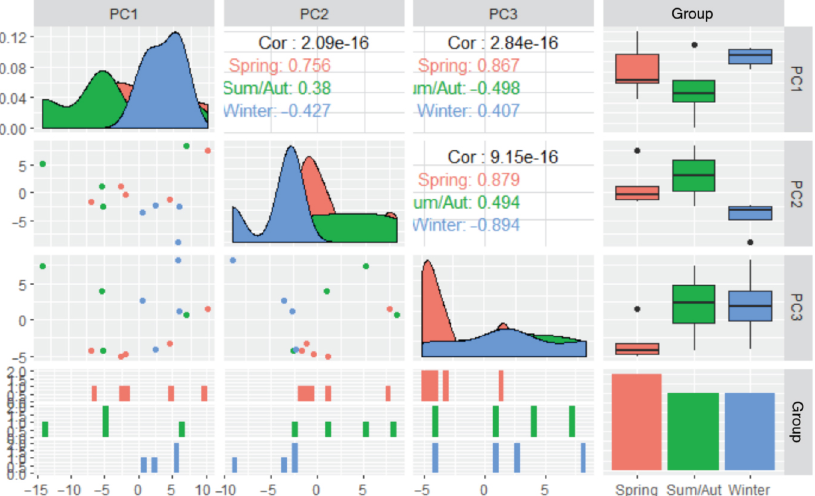
Figure 4: PCA pairs plot of the first three components. The variables in pink correspond to the spring group, the green ones to the summer/autumn group and the blue to the winter group.